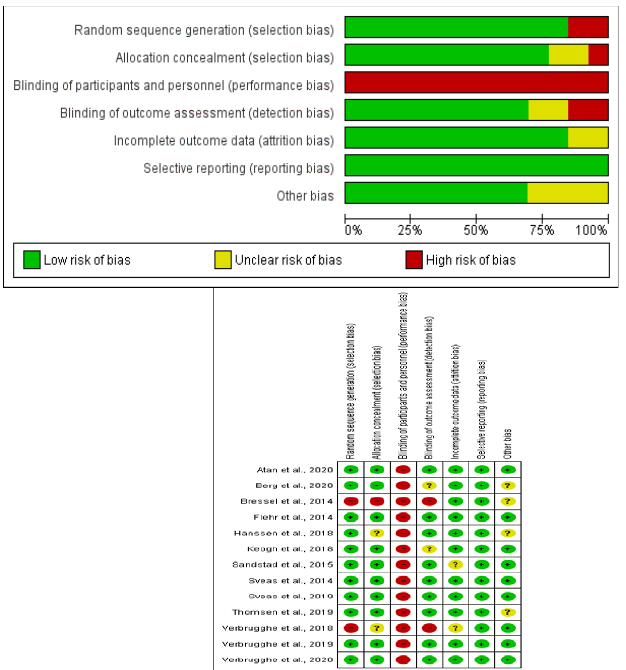
Figure 2. Risk of bias summary. Review authors’ judgements about each risk of bias item for each included study (Risk of Bias scale) and risk of bias graph. Review authors’ judgements about each risk of bias item presented as percentages across all included studies (Risk of Bias scale). Table 3. Assessment of the studies’ quality based on the PEDro Scale.